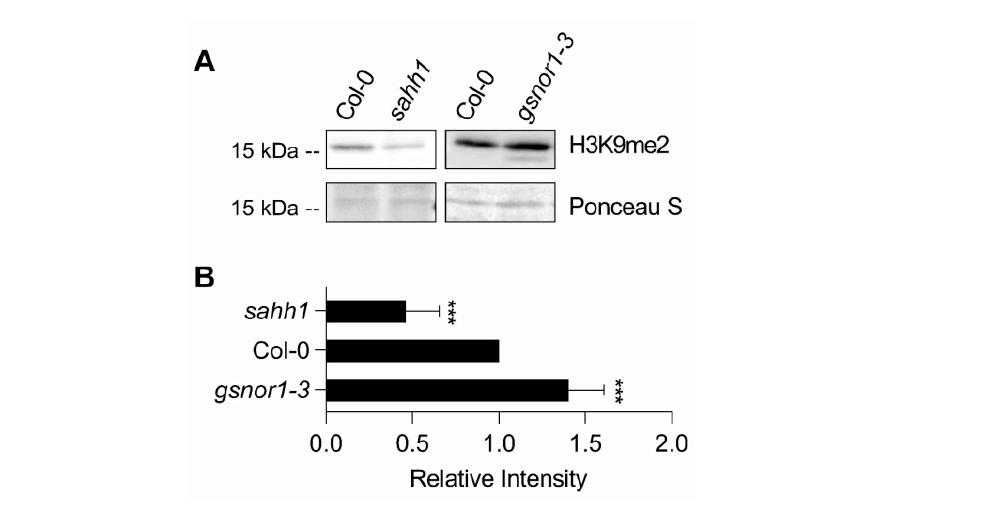
Figure 2. Histone H3K9me2 methylation level is altered in gsnor1-3 and sahh1 . ( A ) H3K9me2 immunoblot. Histones were acid extracted from 4-week-old rosette leaves grown under long-day conditions and harvested 5 h after the day-time start and probed against H3K9me2 marks by immunoblotting. As the loading control, the Ponceau S-stained membrane is shown. One representative experiment is shown. (B) Quantification of immunoblot results. Signal intensities were measured using ImageJ software and normalized to the amount of loaded H3. Statistics: values are expressed as fold change over wt and represent the mean ± SD of at least three independent experiments ( n = 4–7). Grubb´s outlier test ( α = 0.05) was performed. ***( p < 0.001) represents significant differences between wt and mutant lines (ANOVA, Dunnett´s multiple comparisons test). Statistical analysis was performed with GraphPad Prism version 7.05.